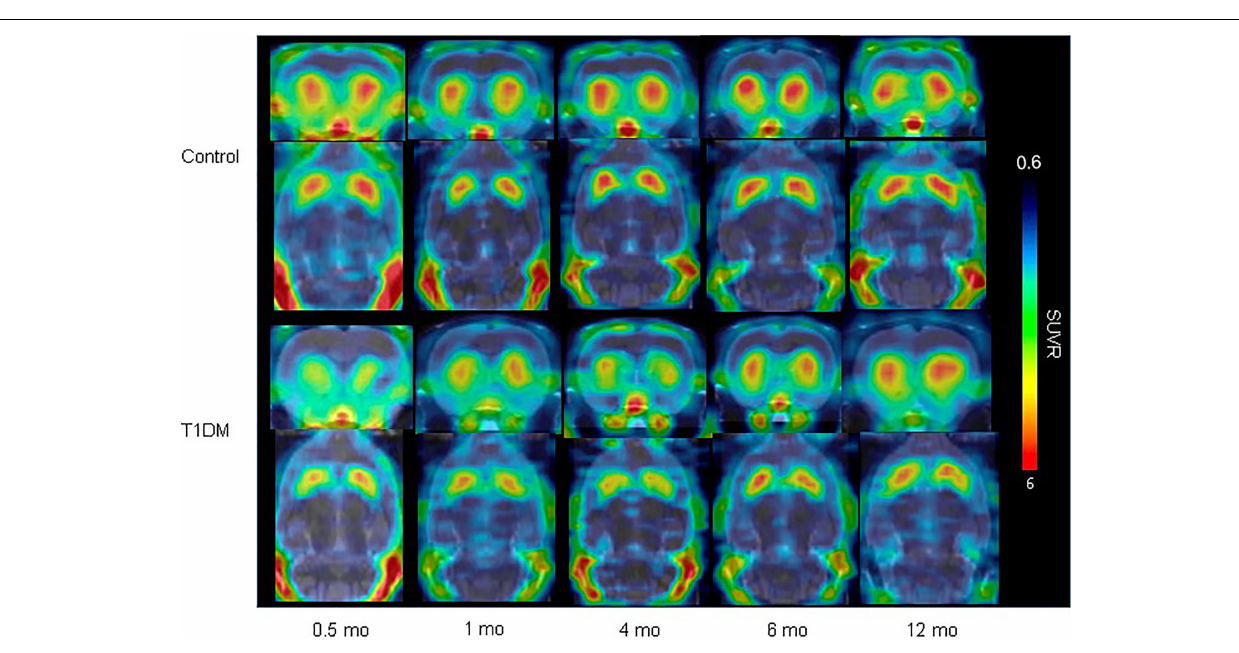
FIGURE 5 | VMAT2 expression in the striatum in type 1 DM (Jiang et al., 2020) (E-produced/adapted from Nuclear Medicine and Biology, used with permission) Shown is the decreased VMAT2 expression in the striatum in a rat model of T1DM, and in control rats, 0.5, 1, 4, 6, and 12 months after model induction, as